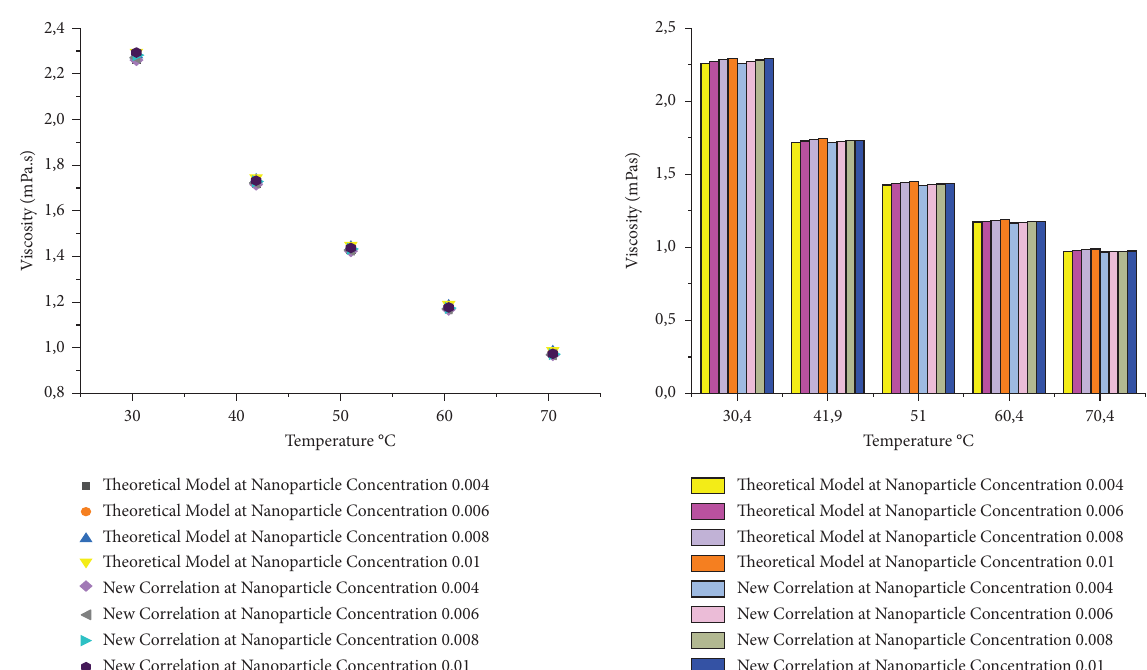
Figure 1: Comparison of titanium oxide-ethylene glycol (40%)/water (60%) nanofuid viscosity theoretical model and new correlation.